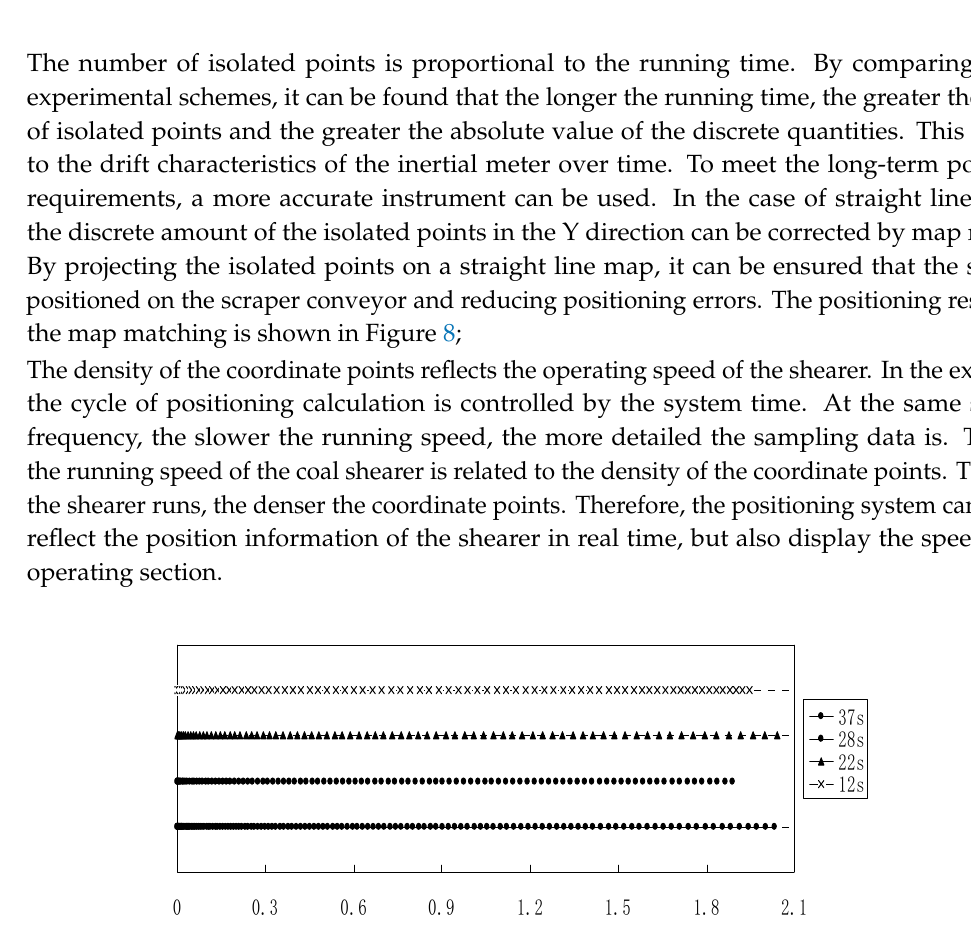
Figure 8. Map matching results at different runtimes.